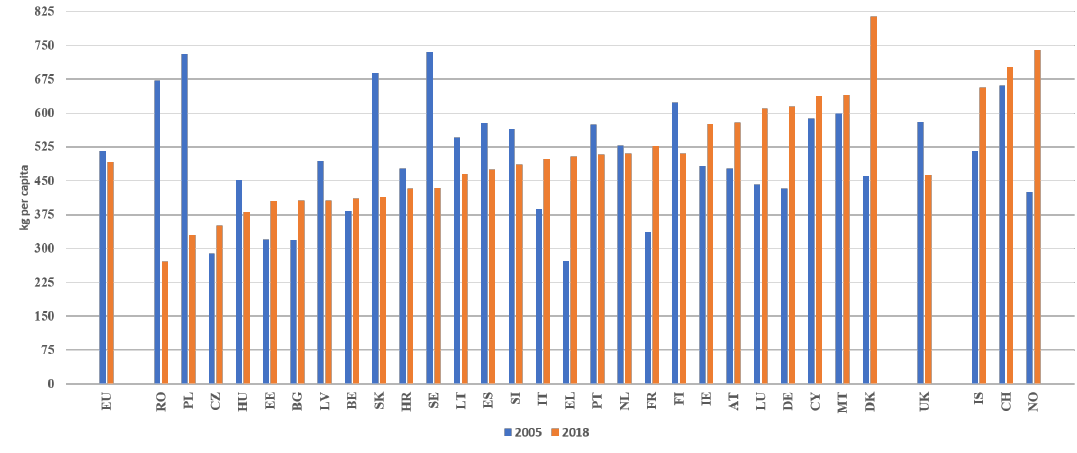
Figure 2. Municipal waste generation in the European Union (EU) 1995 and 2018